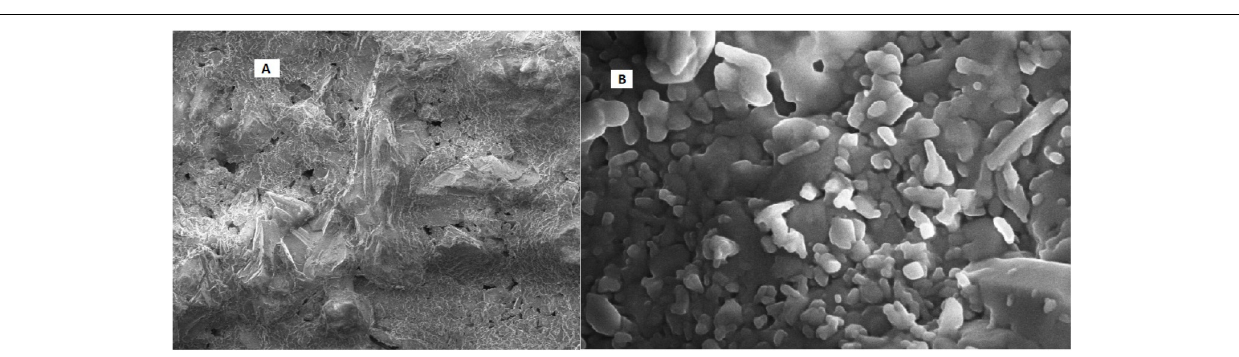
FIGURE 10 | (A) SEM image of the untreated core which clearly displays the presence of pores. (B) Treated core was indicating the plugging of pores by microbial consortia TERIJ-188 in core flood